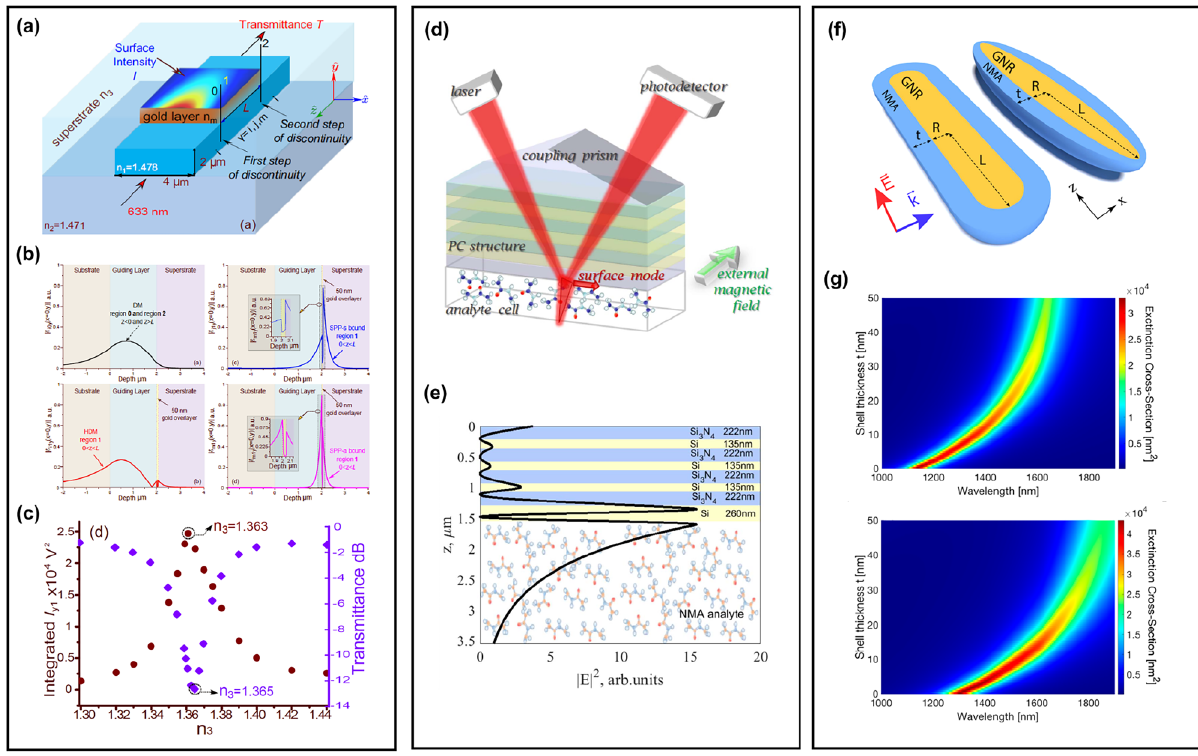
Figure 6: Surface plasmon-based waveguide sensors. (a) 3D schematic of composite plasmonic waveguide. (b) Cross-sections of the y-component of the electric field magnitude for the structure: a purely dielectric mode (DM) in a dielectric waveguide and in a gold coated region for hybrid dielectric mode (HDM), SPP-s and SPP-a. (c) The superstrate indices, n 3 which yield the minimum in transmittance and the maximum in integrated surface intensity ((a) – (c) are reproduced from [3]). (d) Schematic representation of the multilayered stack of the photonic crystal (PC) nanostructure sensor. (e) PC structure scheme and the electromagnetic fi eld distribution of the mode inside the PC structure and NMA analyte ((d) and (e) are reproduced from [89]). (f) Schematics of systems with gold nanorods (left) studied in numerical simulations and nanoellipsoids (right) used in the analytical model. (g) Extinction cross-sections of gold nanoellipsoids with NMA shells of differentthicknesses(top).Thesemi-majoraxisof thegoldcoreis L =55.9nm(bottom).Thesemi-majoraxisofthegoldcoreis L =68.1nm((f) and (g) are reproduced from